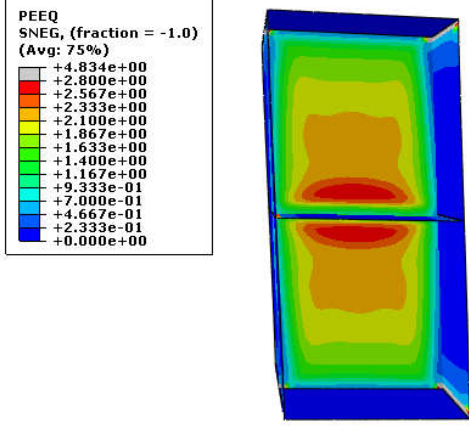
Figure 6. The stresses formed in sample BT150 mm, 4 mm (kN/mm 2 ).